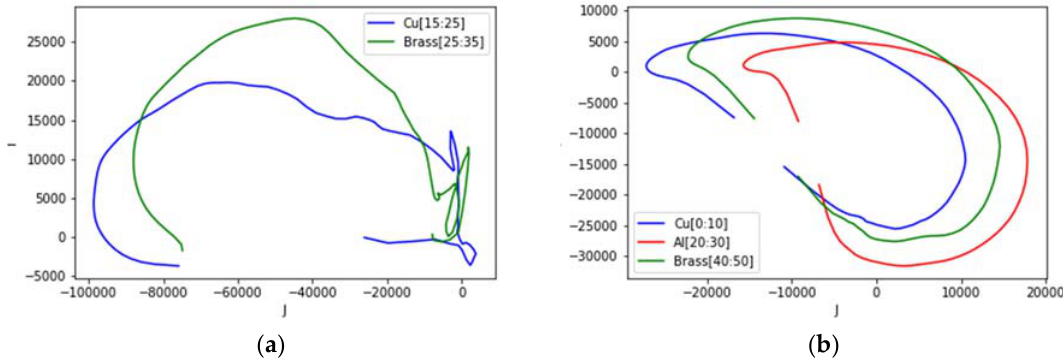
Figure 27. Complex plot of impedance for different samples at different locations: ( a ) two samples at left and right side; ( b ) three samples located at left, centre and right side.